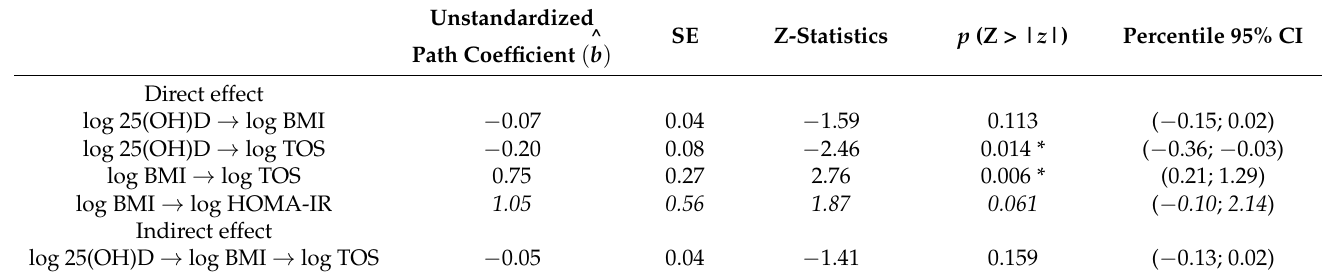
Table 4. Path coefficients of the conceptual model.